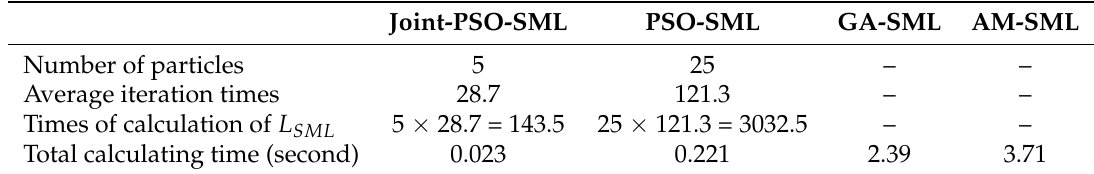
Table 7. Comparison of computational complexity of Joint-PSO, PSO, GA and AM for SML. Scenario: p = 8, q = 2, r = 2, N = 100, SNR = 0 dB, The ture DOA: 30 ◦ and 29.5 ◦ (close sources), 30 independent trials, RMSE = 0.45.